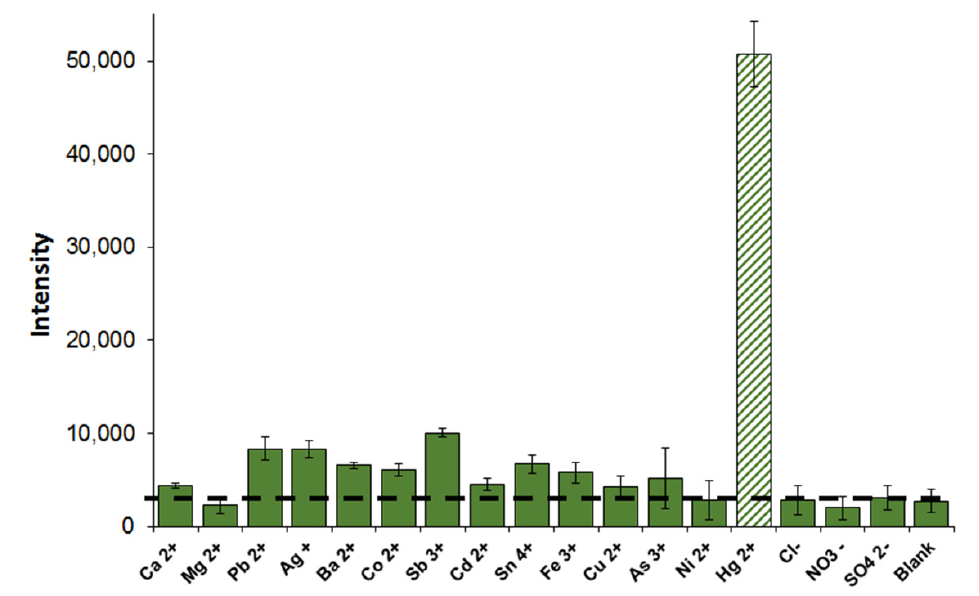
Figure 9. The color intensity in the test zone in the presence of various metal ions. The concentration of each metal ion was 100 ng/mL. Error bars show the standard deviation from three replicate meas- urements.